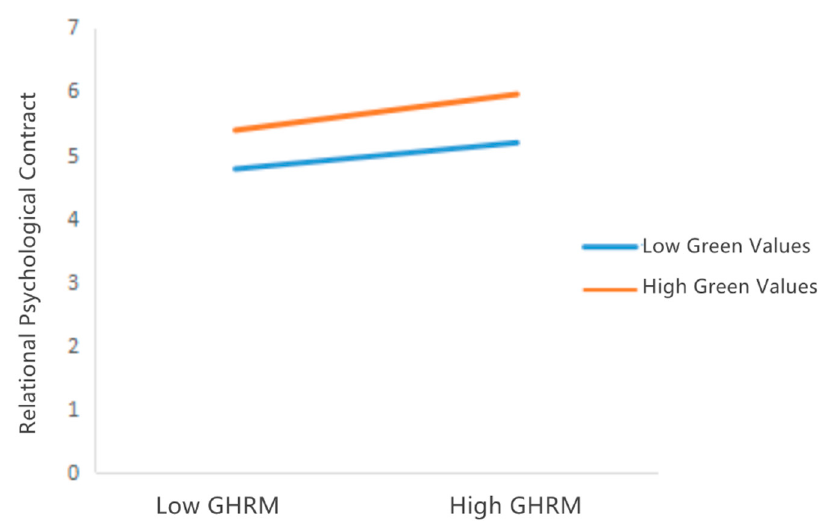
Figure 3. Moderating effect of green values between GHRM and the relational psychological con ‐ tract.